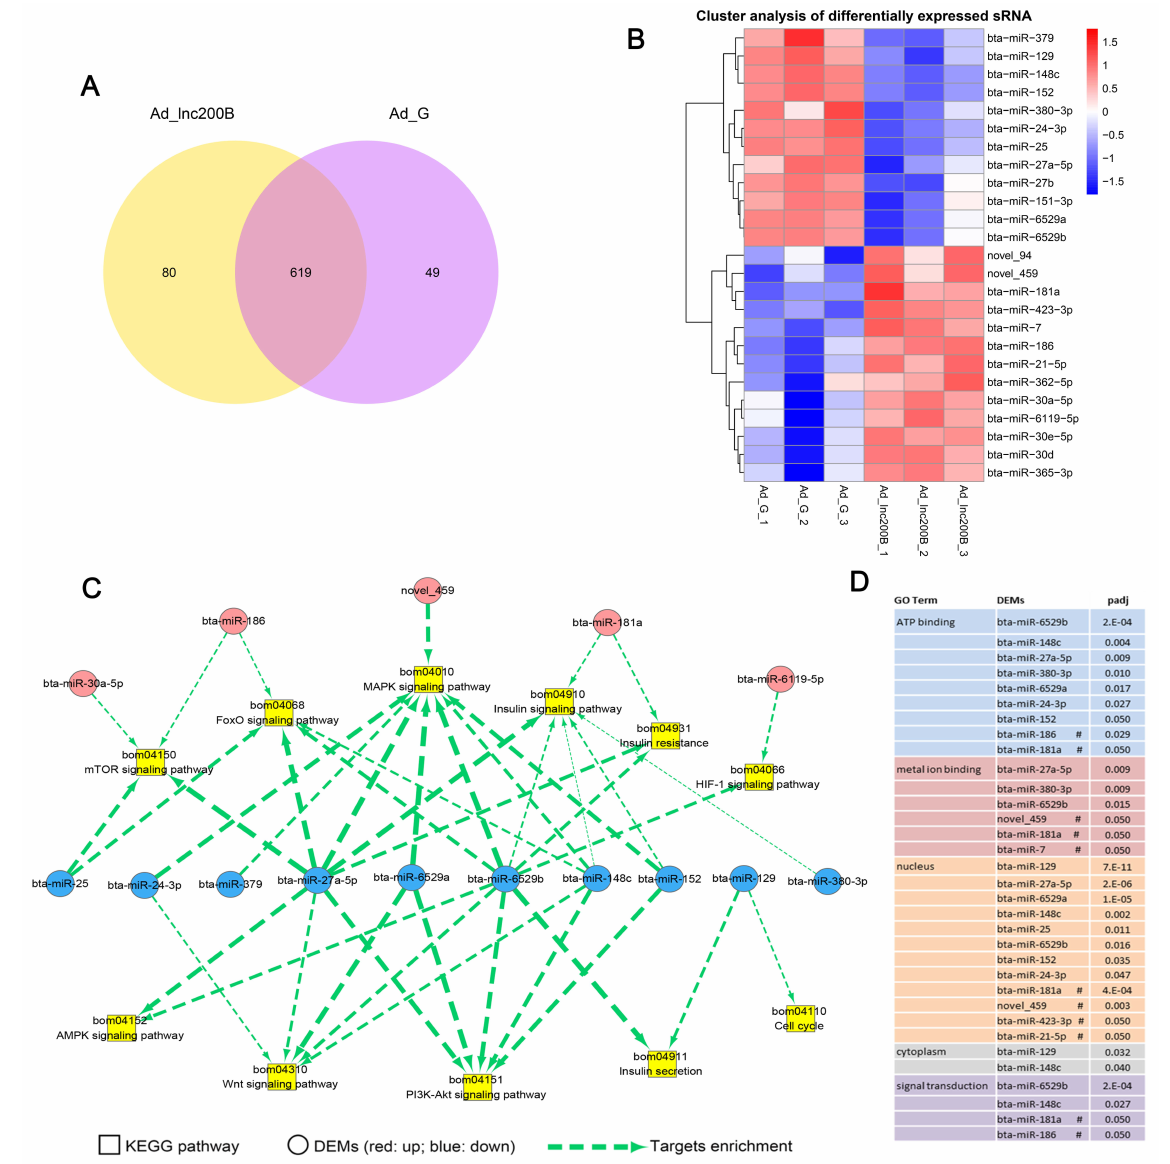
Figure 2. DEMs analysis after lncFAM200B overexpression. ( A ) The Venn diagrams of the DEMs between Ad_lnc200B and Ad_G. ( B ) Clustering map of DEMs. Statistics of adipogenesis-related pathway and main GO terms in DEMs targets. ( C ) Analysis of DEMs in adipogenesis-related KEGG pathway. The thickness of the line is negatively correlated with the padj. ( D ) Main GO term in the DEMs target. # marks the up-regulated DEMs, the others are down-regulated